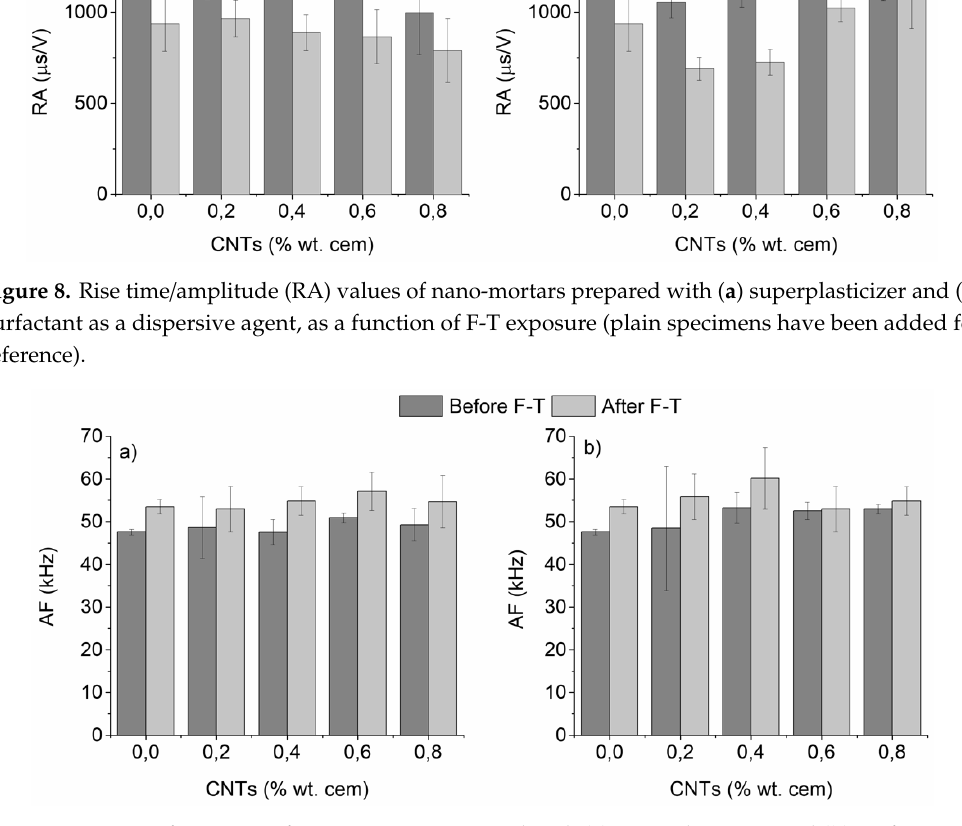
Figure 9. Average frequency of nano-mortars prepared with ( a ) superplasticizer and ( b ) surfactant as a dispersive agent, as a function of F-T exposure (plain specimens have been added for